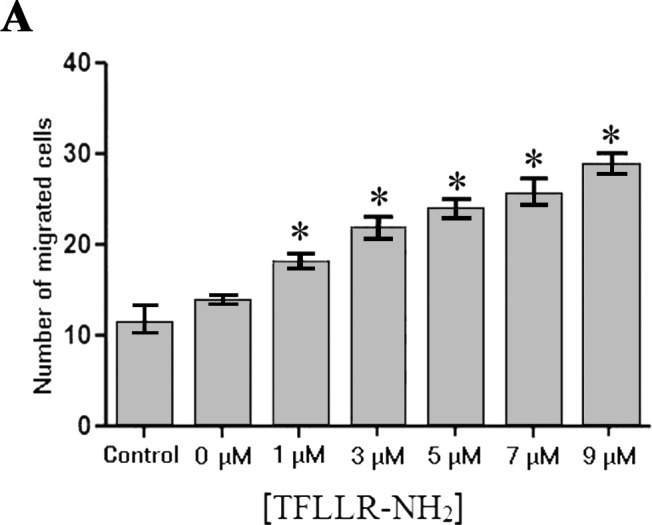
(A) Migration of the SW620 cells induced by platelet activation examined by Transwell migration assay. The number of the migrated SW620 cells induced by platelet supernatants extracted from the platelets activated by different concentrations of TFLLR-NH2. *P<0.05 compared to the control. (B) Fluorescence microscopy image of the upper Transwell chamber after migration of the SW620 cells towards the activated platelet supernatant. The nuclei were stained with DAPI. (a) Media only control, (b) no TFLLR-NH2 in the platelet culture, (c) 1 μM TFLLR-NH2 and (d) 7 μM TFLLR-NH2.